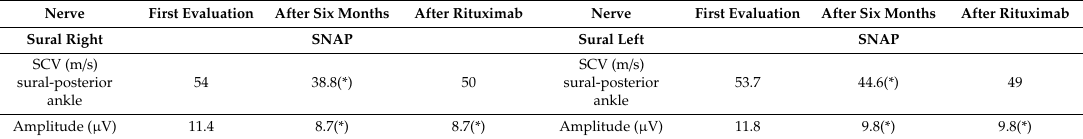
Table 1: Nerve conduction studies of upper and lower limbs in our patient. DML: Distal motor latency; MCV: Motor conduction velocity; SCV: Sensory conduction velocity; CMAP: Compound muscle action potential; SNAP: Sensory nerve action potential. Reference values for healthy subjects in our laboratory for motor conduction studies were the following: Ulnar motor nerve, DML 2.4 ( ± 0.5) ms, MCV 57 ( ± 8.4) m / s, CMAP 8.9 ( ± 2.8) mV, record: Abductor digiti minimi; Median motor nerve, DML 2.9 ( ± 0.16) ms, MCV 60.25 ( ± 2.99) m / s, CMAP 8,5 ( ± 2.8) mV, record: Abductor pollicis brevis; Peroneal motor nerve, DML 3.8 ( ± 0.6) ms, MCV 48 ( ± 7.6) m / s, CMAP 3.7 ( ± 1.6) mV, record: Extensor digitorum brevis (EDB); Tibial motor nerve, DML 4.5 ( ± 0.8) ms, MCV 48 ( ± 7.6) m / s, CMAP 9.8 ( ± 4.2) mV, record: Abductor hallucis brevis. Ulnar F wave latency: ≤ 32; Median F wave latency: ≤ 31; Tibial F wave latency: ≤ 56. Reference values for healthy subjects in our laboratory for sensory conduction studies were the following: Ulnar sensory nerve, SCV 55 ( ± 5.1) m / s, SNAP 21.6 ( ± 16.2) µ V; Median sensory nerve, SCV 40 ( ± 15) ms, Amplitude 21.8 ( ± 10.7) µ V; Sural nerve, SCV 53 ( ± 5.4) m / s, SNAP 21.0 ( ± 9.8) µ V. (*) = Out of limit values. Brain and spinal cord MRI showed an enlargement of cervical and lumbar roots without gadolinium enhancement as for chronic roots inflammation, in absence of intramedullary lesions Figure 1.